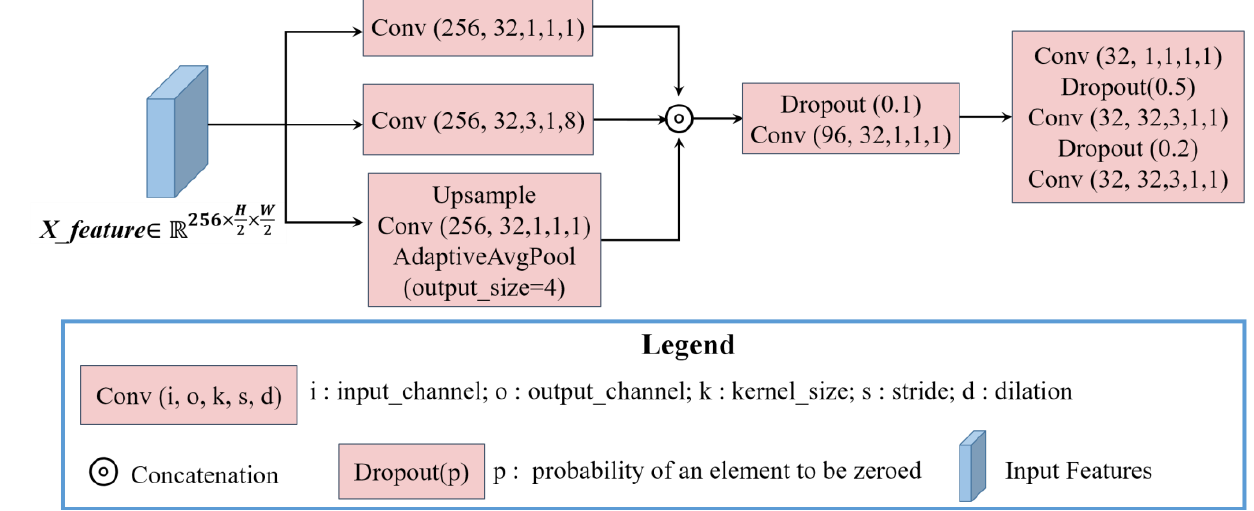
Figure 3. The architecture of the Light-ASPP module.